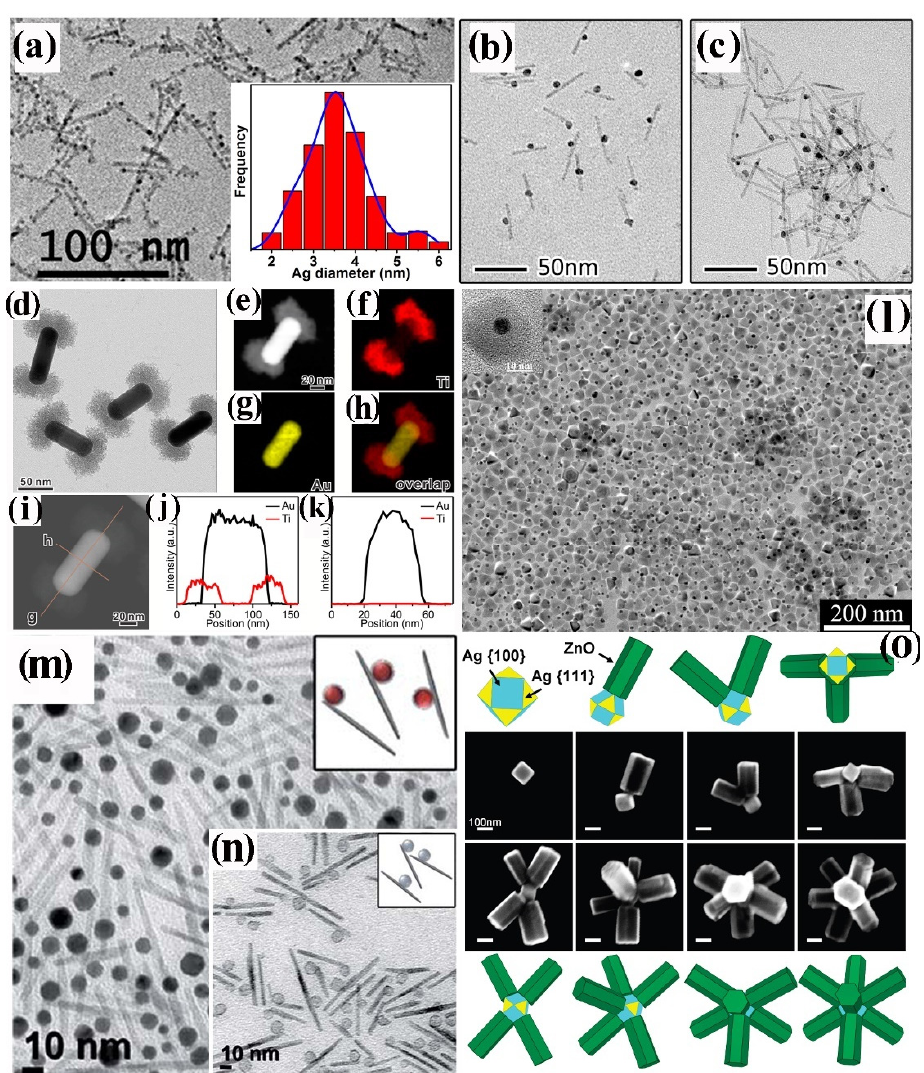
Figure 10. Gallery of representative two-component anisotropic CNHSs synthesized by site-selective heterogeneous deposition on preformed seeds with variable shapes (cf. Scheme 4). ( a ) TEM image of Ag-TiO 2 CNHSs composed of multiply Ag–decorated TiO 2 nanorods; with the Ag size histogram in the inset (reproduced with permission from Ref. [338], Copyright 2019, American Chemical Society); ( b , c ) TEM images of binary Ag–TiO 2 CNHSs composed of asymmetrically Ag–decorated TiO 2 nanorods, formed via a photocatalytically driven intraparticle ripening after different UV irradiation times (reproduced with permission from Ref. [340], Copyright 2013, American Chemical Society). ( d ) TEM image, ( e – h ) elemental EXD maps, ( i ) HAADF-STEM image and elemental EDX profiles ( j , k ) of nanodumbbell-like CNHSs individually composed of one Au nanorod equipped with extended TiO 2 heads at the apexes (reproduced with permission from Ref. [341]; Copyright 2016, American Chemical Society). ( l ) TEM image (HRTEM image in the inset) of Au–ZnO CNHSs composed of a ZnO nanopyramid connecte to a single Au domain at its basal side (reproduced